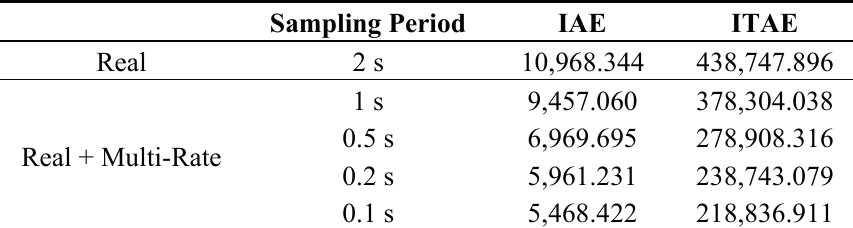
Table 2. Performance indexes of the WNCS for real sampling of 2 s and soft sensor and multi-rate of 1, 0.5, 0.2 and 0.1 s.